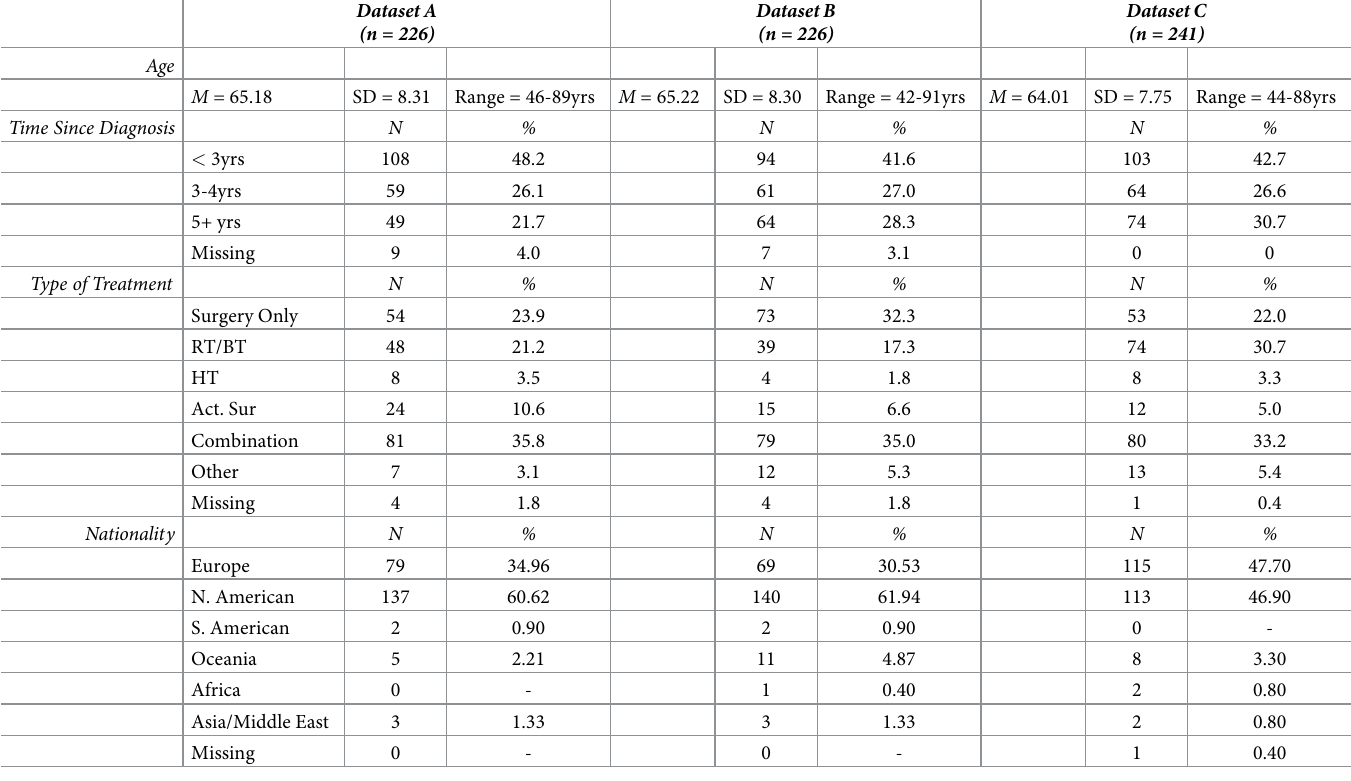
Table 1. Demographic information of Dataset A, B and